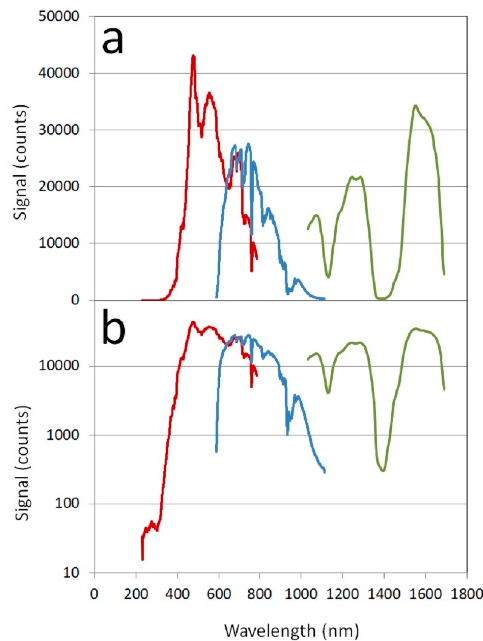
Figure 1. ( a ) Three spectra acquired along 1 sec interval of measurement, for stable and clean sky conditions and high solar flux (28 June 2017 at 9:35 UTC). The spectra acquired by SPC1, SPC2 and SPC3 are in red, blue and green, respectively. ( b ) The same spectra represented in a logarithm scale. Stray light effects are very noticeable in the SPC1 spectrum for wavelengths below 320 nm.